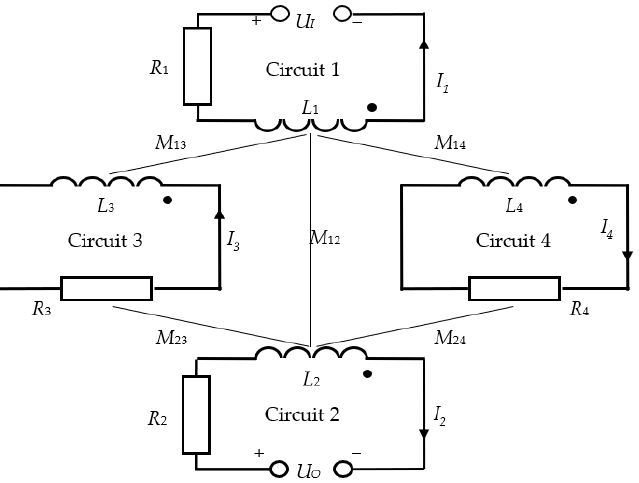
Figure 1. ( a ) Schematic diagram of electromagnetic distribution on the surface of the pipeline without defects; ( b ) schematic diagram of electromagnetic distribution on the surface of the pipeline with cracks.